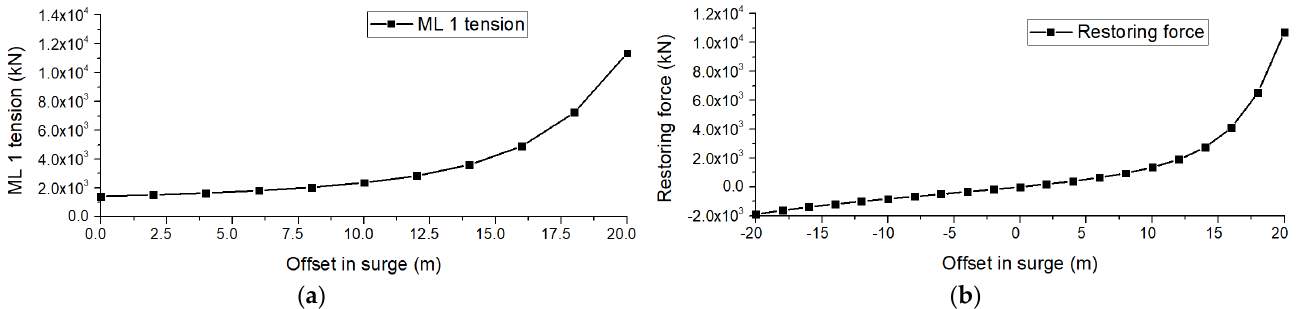
Figure 9. Mooring line force and restoring force in surge vs. offset in surge: ( a ) ML 1 tension; ( b ) Restoring force. Table 3. Mooring line properties of WindFloat SFOWT.